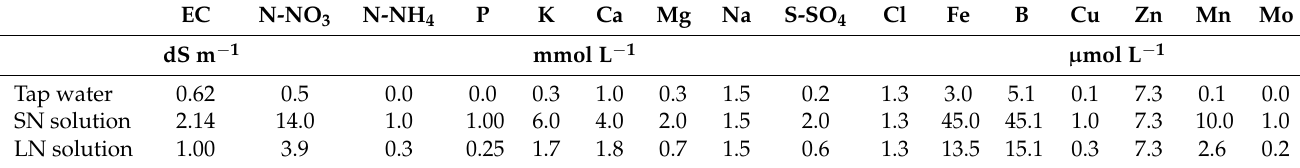
Table 1. Electrical conductivity (EC) and concentrations of macro and micronutrient in standard (SN) and low-concentrated (LN) nutrient solutions and in the tap water used for their